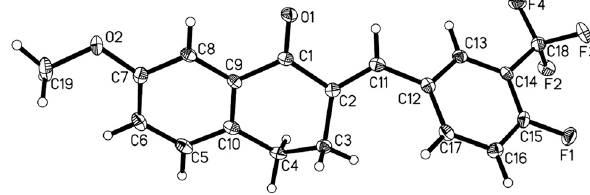
Table  : Data collection and handling.